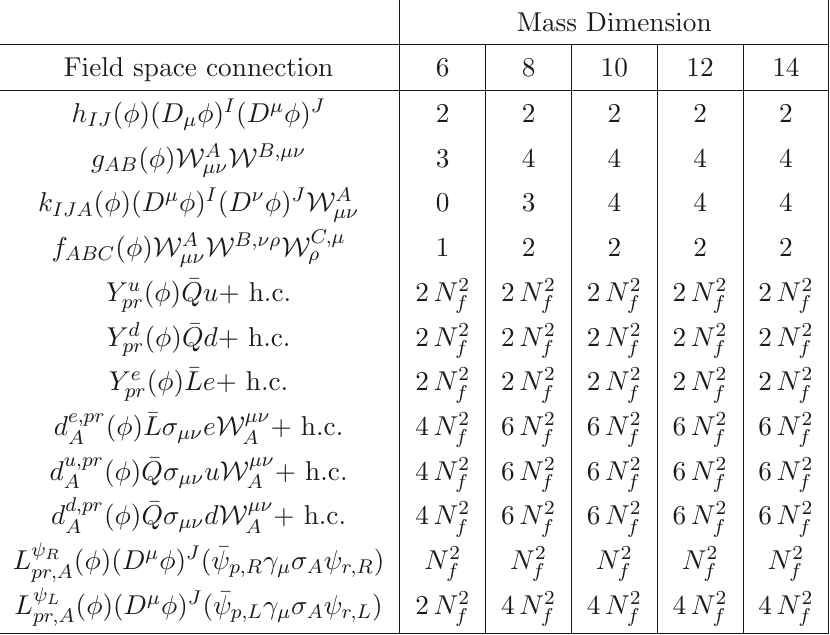
Table 1 . Counting of operators contributing to two- and three-point functions from Hilbert series. These results are consistent with ref.